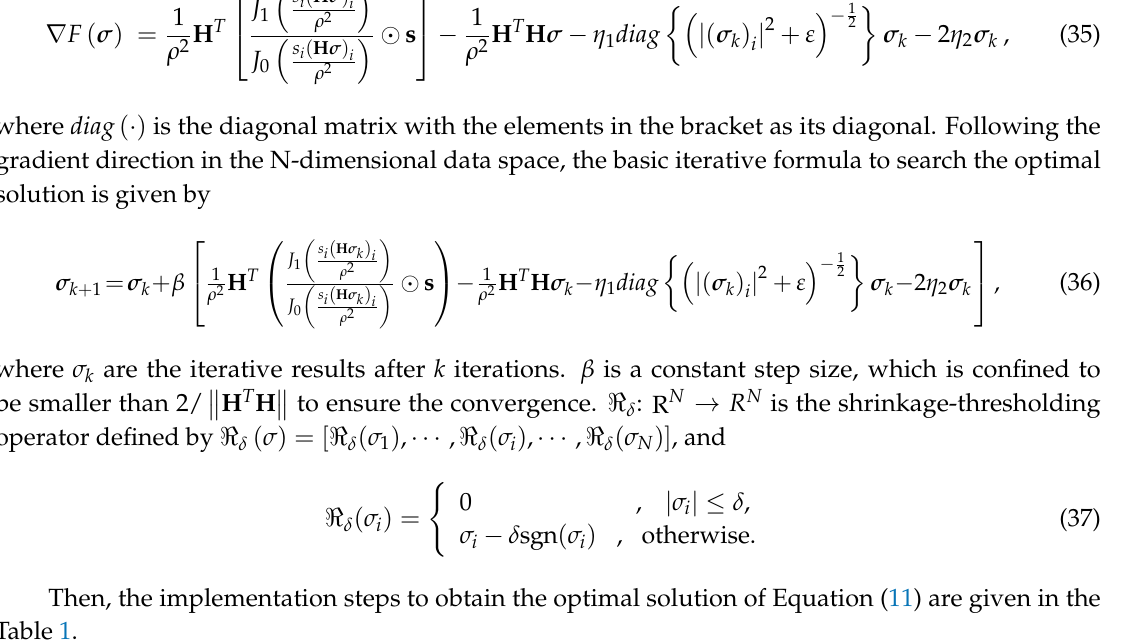
Table 1. The flowchart of the accelerated iterative shrinkage/thresholding solution strategy. Initial Step : Take σ 0 = s , compute the first two iterative results σ 1 and σ 2 through the basic iteration formula Equation (36) and the first two iterative vectors g 1 = σ 1 − σ 0 and g 2 = σ 2 − σ 1 Repeat Compute the extrapolation step